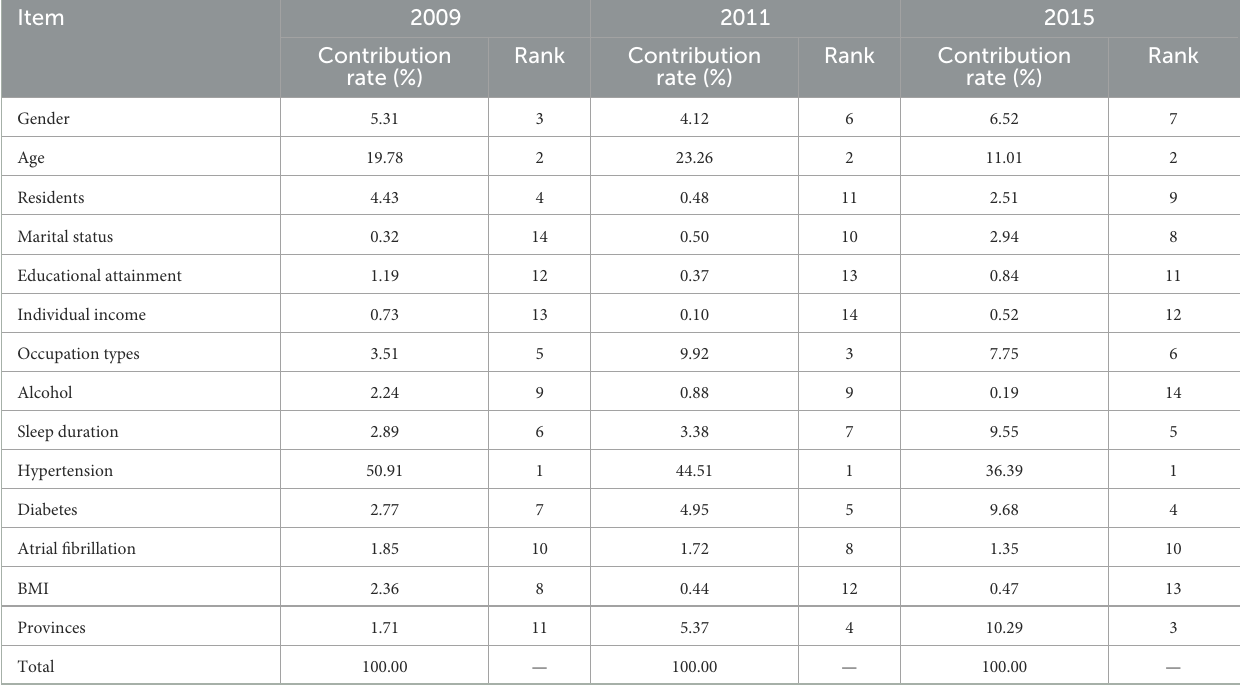
TABLE 2 Shapley value decomposition results of risk factors of